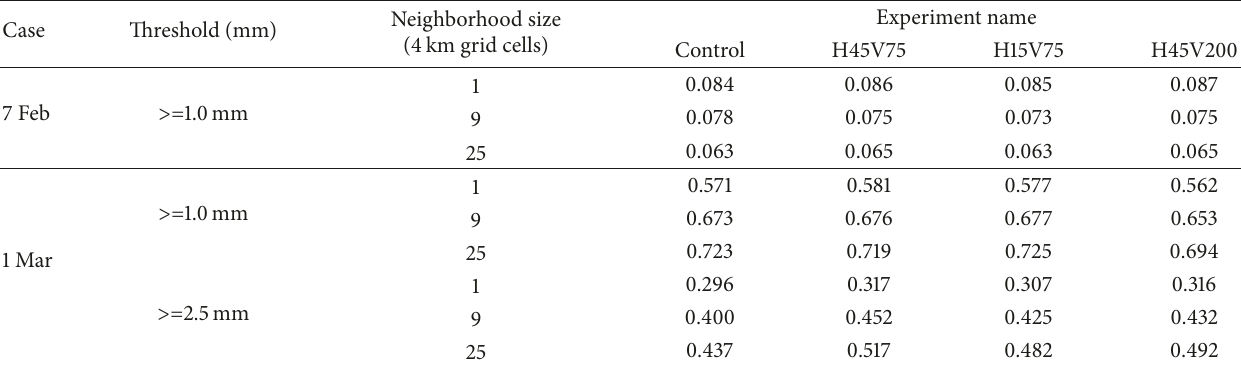
Table 1: FSS for the 0–6 h (18–00 UTC) precipitation forecast for each experiment on the two case days with precipitation during the 0–6h